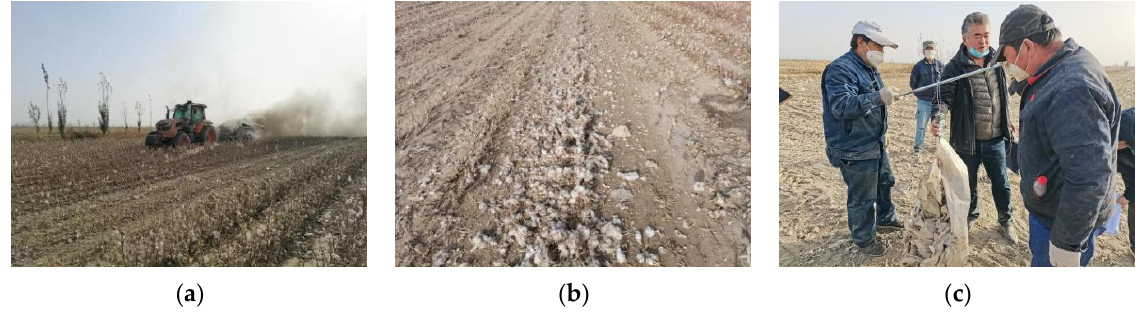
Figure 13. Field performance test. ( a ) Experiment in progress. ( b ) After the operation. ( c ) Weigh impurities and residual film.